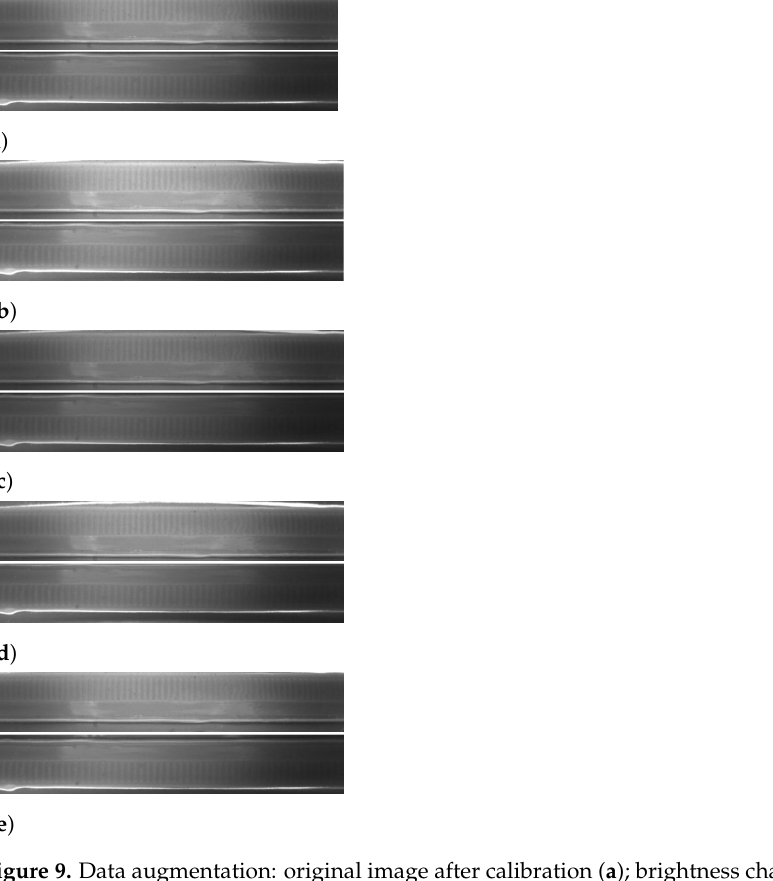
Figure 9. Data augmentation: original image after calibration ( a ); brightness changes of 0.8 and 1.2 ( b , c ); and shifts on y-axis of − 5 px and +5 px ( d , e ). The column “Modes” indicates whether the data were calibrated (preprocessed) and whether the images were analyzed in separate (Separated) or connected (Concat) channels after calibration. The inference times presented in Table 4 are the combined times of results are presented in the following subsections. Table 4. The results of the models’ evaluation. The best results are